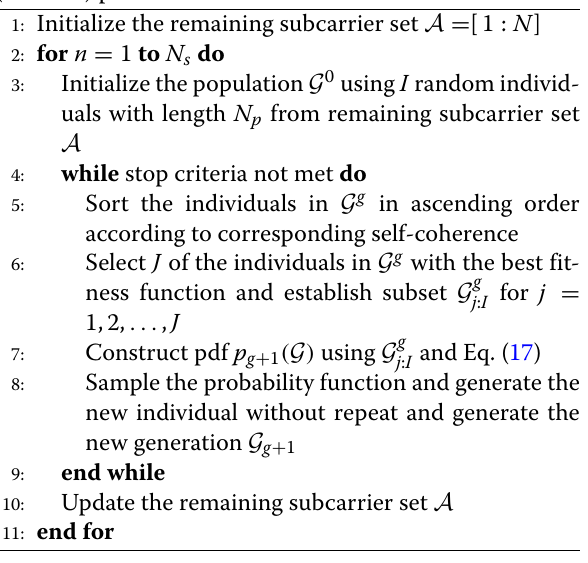
Algorithm 2 Sequential cross entropy self-coherence Algorithm 3 Parallel cross entropy self-coherence (PCE- SC) pilot